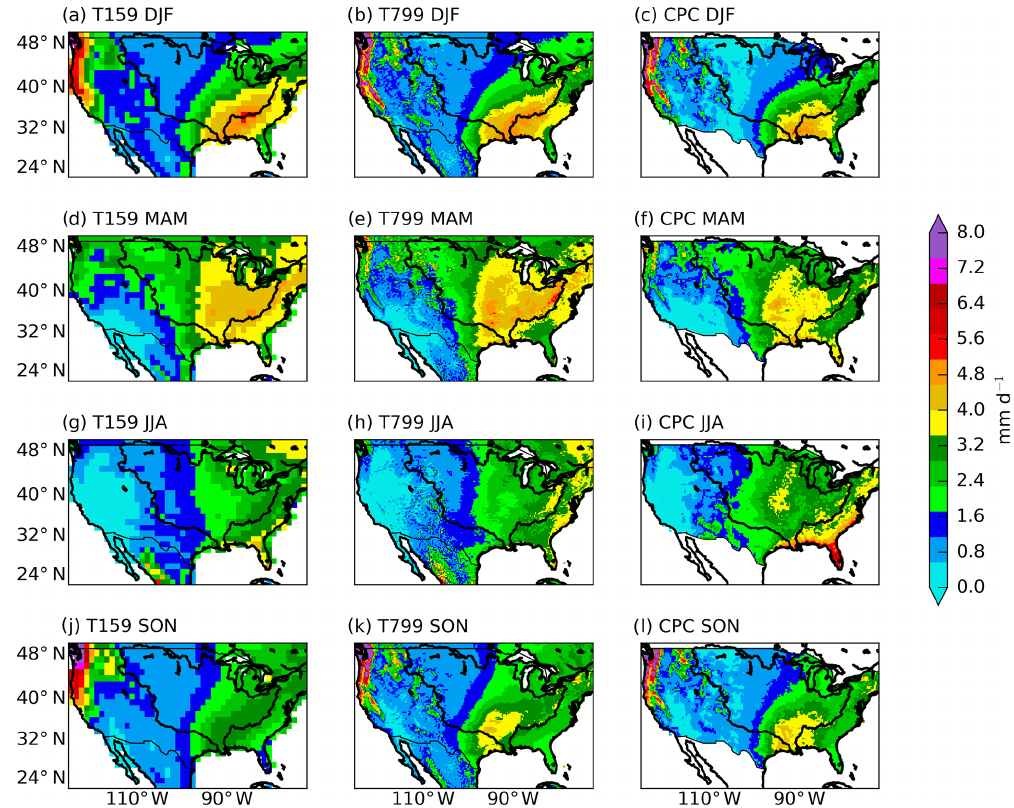
Figure 10. Seasonal means (DJF, MAM, JJA, and SON) of daily precipitation sums (mmday − 1 ) from the low-resolution EC-Earth simula- tions (T159, a, d, g, j ), the high-resolution EC-Earth simulations (T799, b, e, h, k ), and the observations (CPC, c, f, i, l